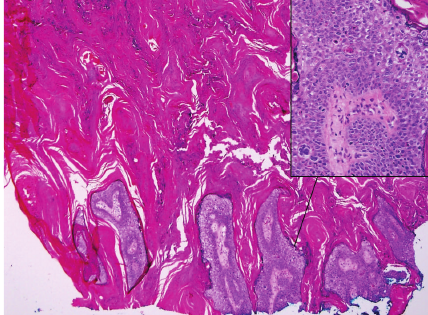
Figure 1: Inverted follicular keratosis: lesion shows proliferative downgrowths of mature squamous epithelium with infundibular keratinization (H&E × 40).